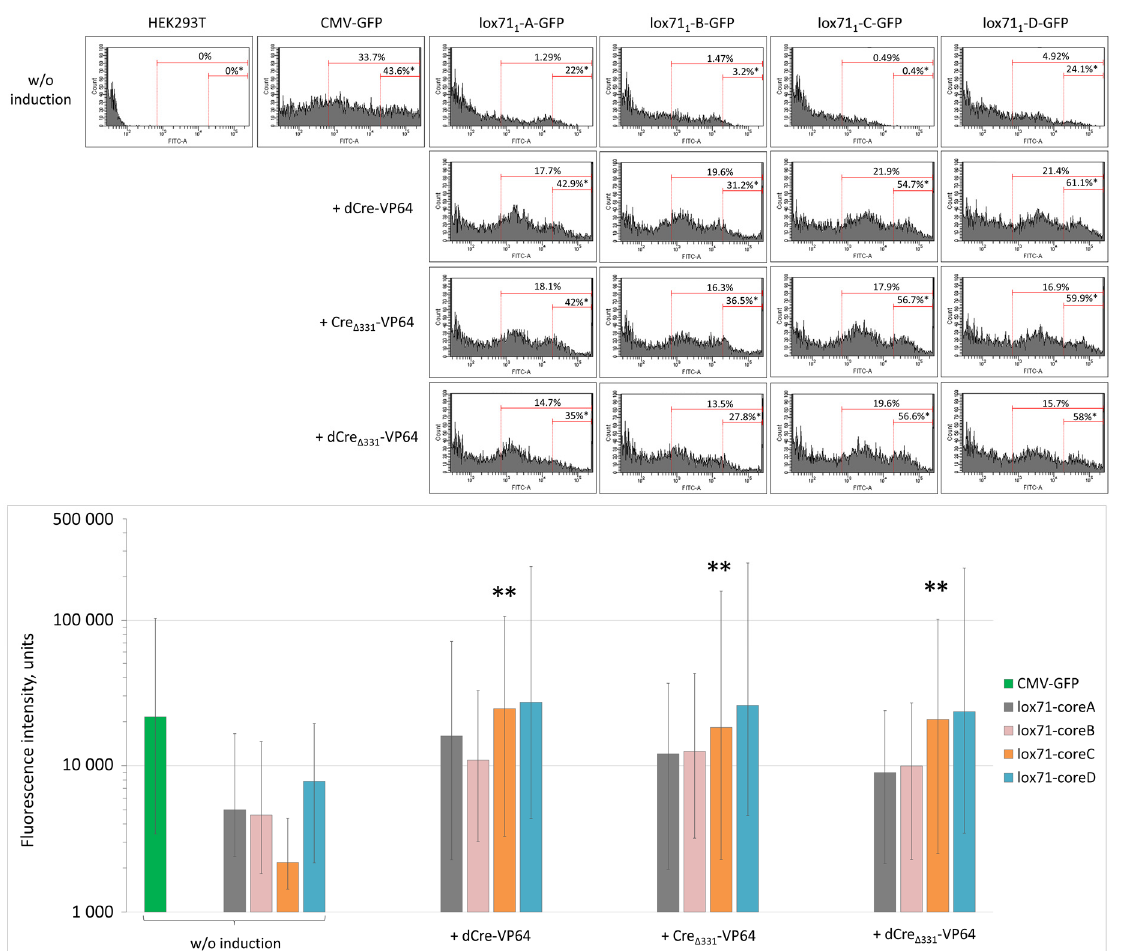
Figure 3. Flow cytometry analysis of GFP expression in HEK293T cells transfected with various combinations of Cre-VP4/lox71 system components. *, The percentage of bright HEK293T cells among all GFP-positive cells; **, p < 0.05 compared to GFP fluorescence intensity of cells transfected with pVax1-lox71 1 -coreC-GFP plasmid without induction, n ≥ 30,000. In the diagram, data are presented as the median (25%;